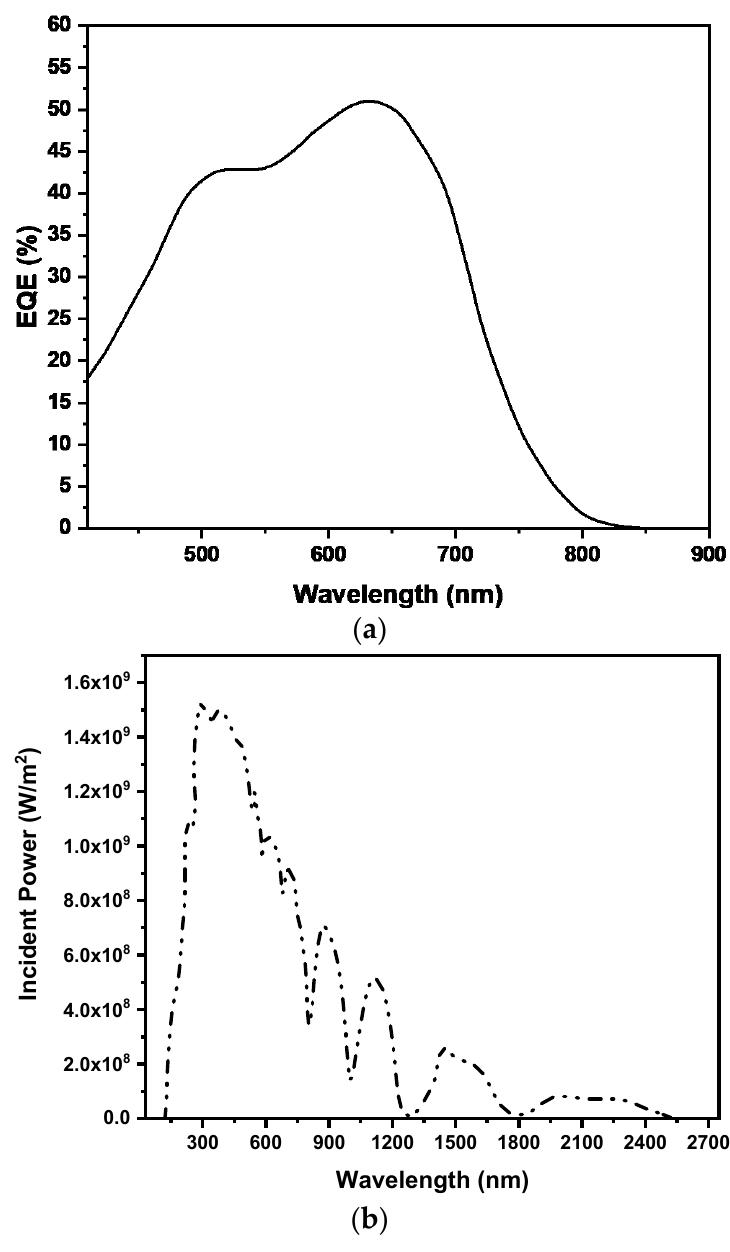
Figure 6. ( a ) EQE spectrum of ITO/PEDOT:PSS/N749-BD/Ag solar cell; ( b ) spectrum of incident light.